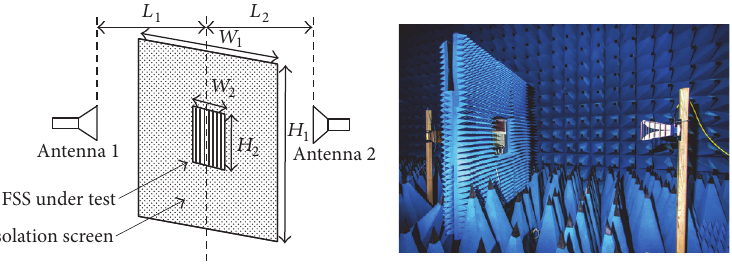
Figure 4: Measurement setup illustration and photo.